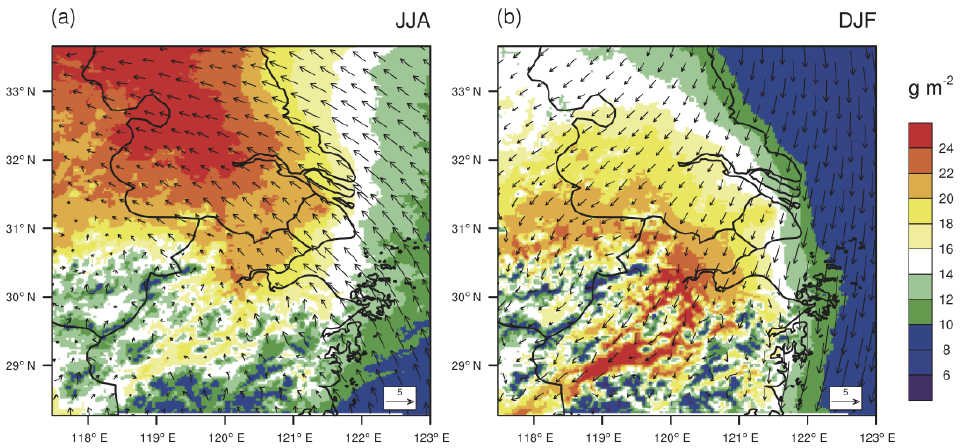
Figure 6. Differences in column burden of PM 2 . 5 (gm − 2 ) between simulations LU70E06 and LU70E70, superimposed with near-surface winds simulated in LU70E70, for (a) summer and (b) winter.